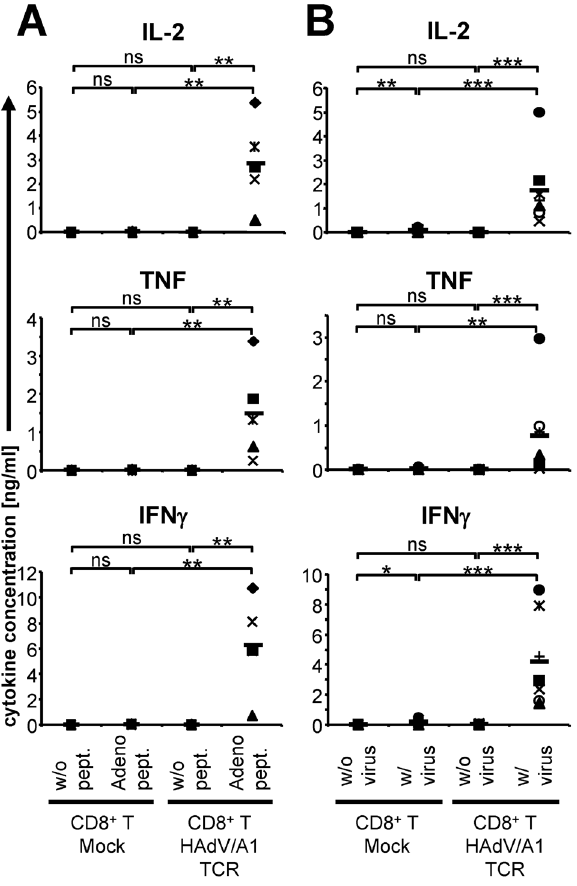
Figure 2. Antigen-specific cytokine production by HAdV/A1- TCR-transfected CD8 + T cells in response to peptide-loaded and adenovirus-infected targets. CD8 + T cells were either mock electroporated or electroporated with HAdV/A1-TCR-RNA and were stimulated with DC, which were either left unloaded ( A : w/o pept., B : w/o virus), or were loaded with the adenovirus peptide (Adeno pept.) ( A ), or were infected with adenovirus (w/virus) ( B ). Cytokine concen- trations (IL-2, TNF, and IFN c ) in the supernatant after over-night co- incubation are depicted. Data of 5 ( A ) and 7 ( B ) individual experiments are shown. Bars indicate mean values. P-values were calculated by the Mann-Whitney U test. ns = not significant, *** p # 0.001; ** p # 0.01; * p # 0.05. Raw data are summarized in Table S2A and B in File